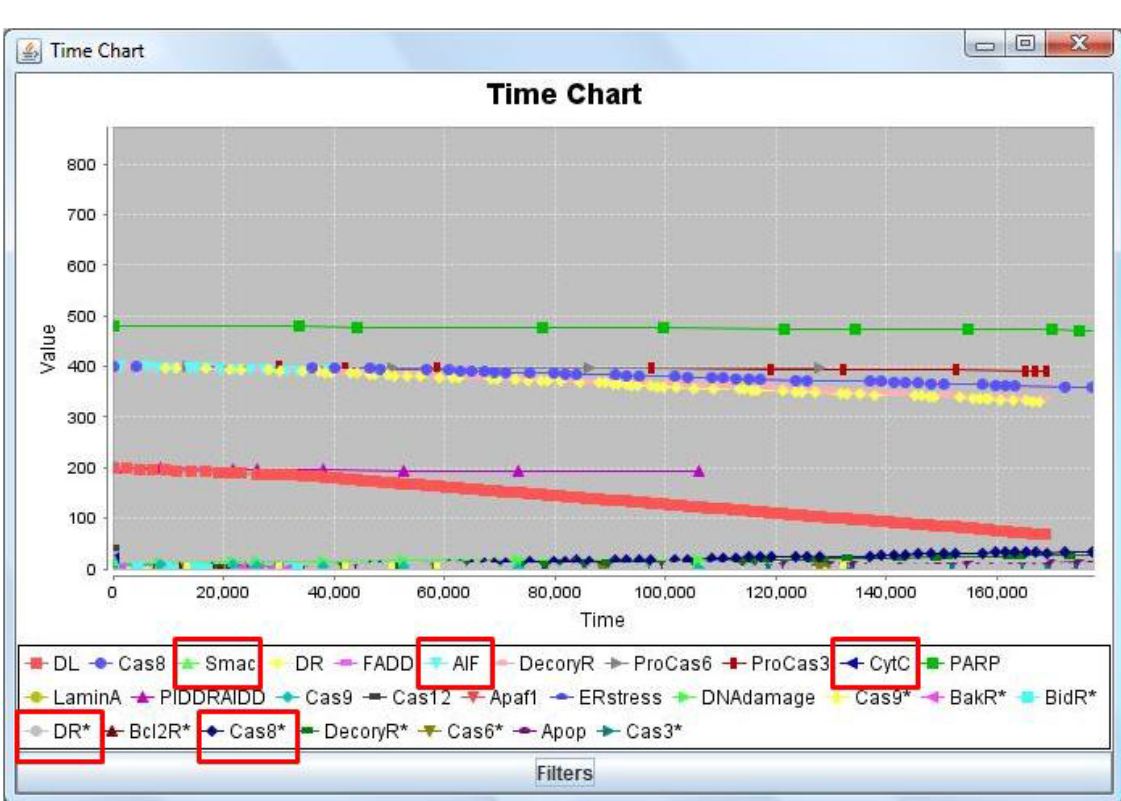
Figure 6: Concentration-time curves: connection between extrinsic and intrinsic